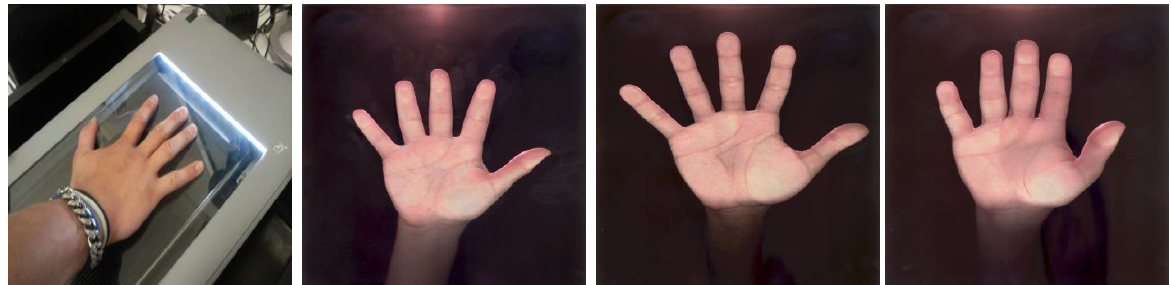
Figure 4. Scanner acquisition (figure on the left) and acquired hand images from three different users (three figures on the right).